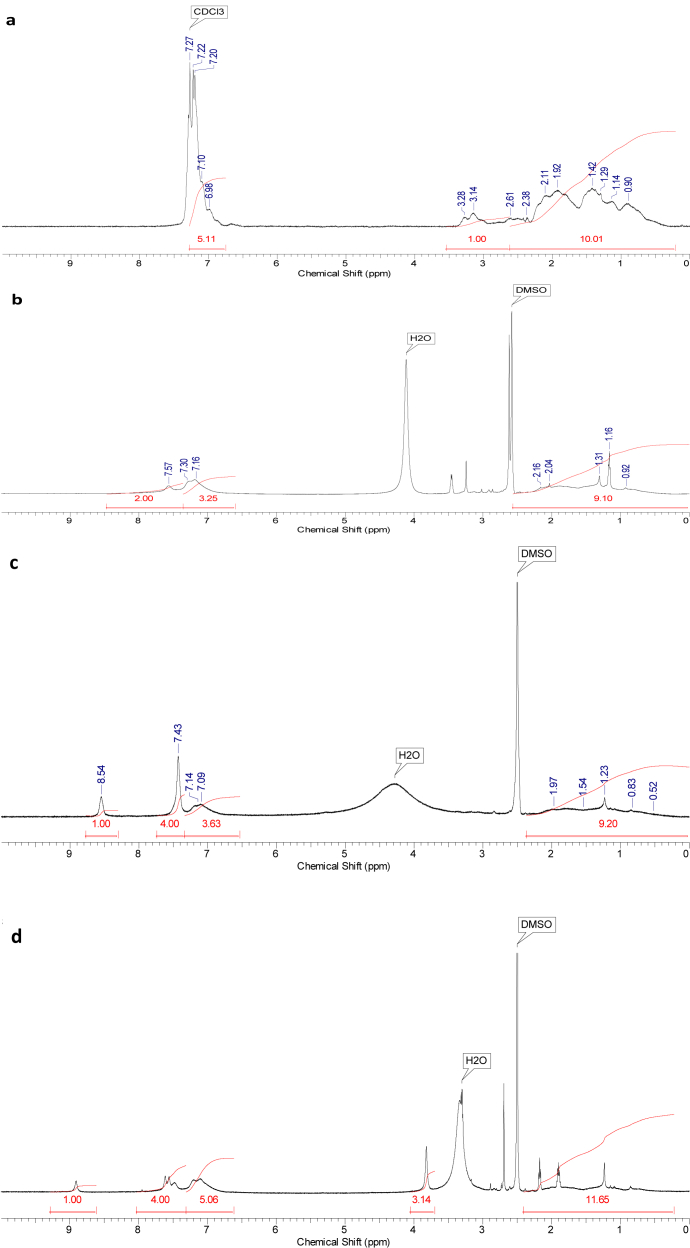
1H NMR spectra of HPPhNB (a), SHPPhNB (b), SHPPhNB-Im (c) and SHPPhNB-MIm (d).